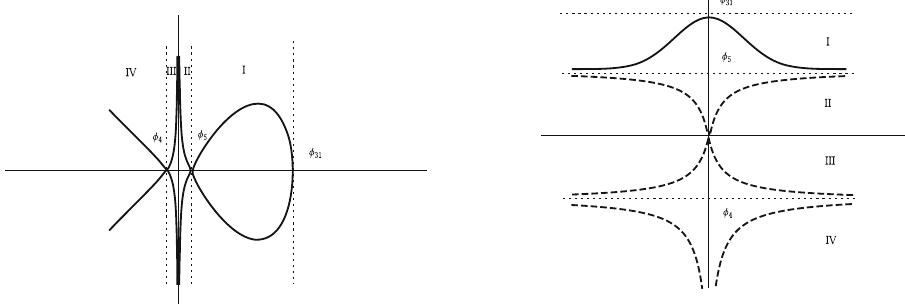
Figure 5: The graphs of the phase - portrait and the wave pro fi le when ( ) P ϕ has two double roots ϕ